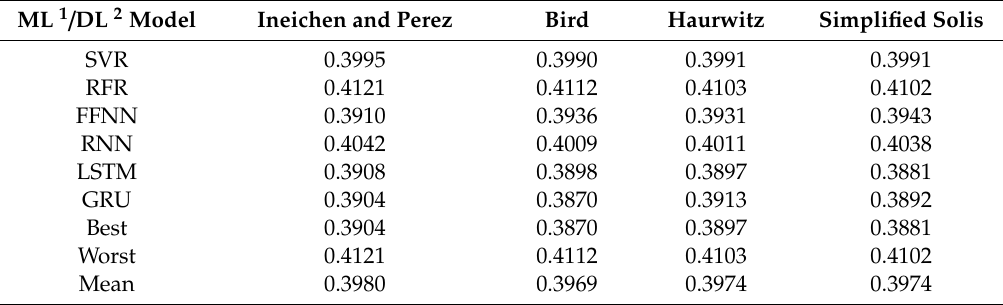
Table 1. RMSE for different clear sky GHI models.